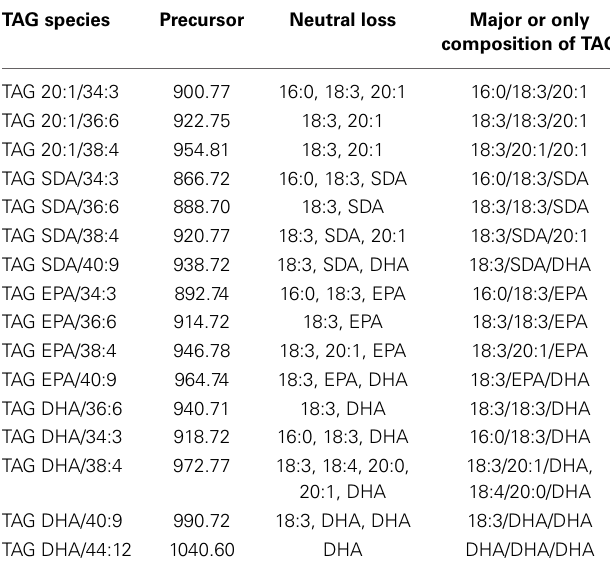
Table 2 | MS/MS fragmentation and structure analysis of the selected TAG species. TAG species Precursor Neutral